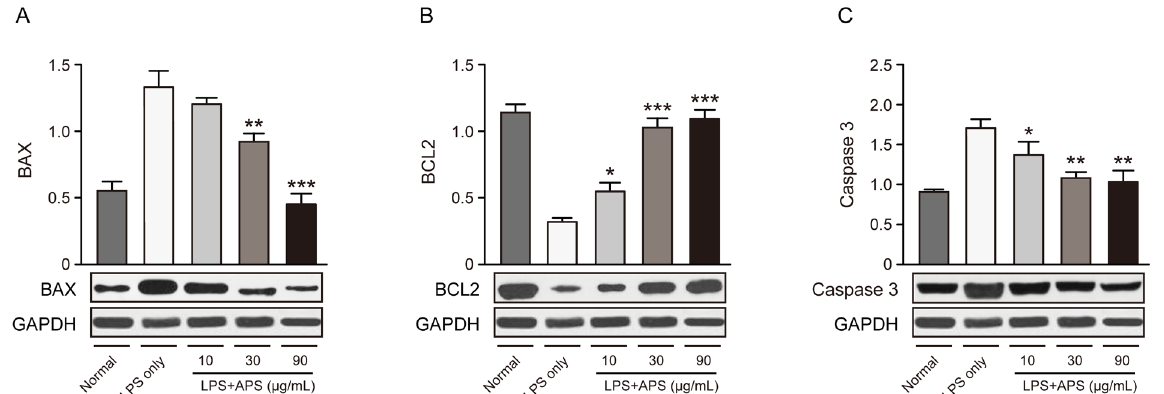
Figure 2. Effects of APS incubation on the expression of the apoptosis-related indicators. The expression analysis of (a) BAX, (b) BCL2 and (c) Caspase 3 in western blotting detection. * = p < 0.05, ** = p < 0.02, *** = p < 0.001 vs. LPS treated only cell group. Values represent mean ± SD of 5 independent